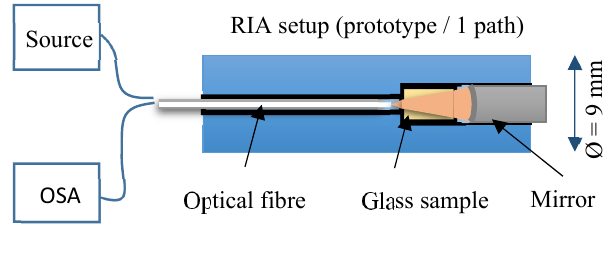
Figure 2: RIA setup